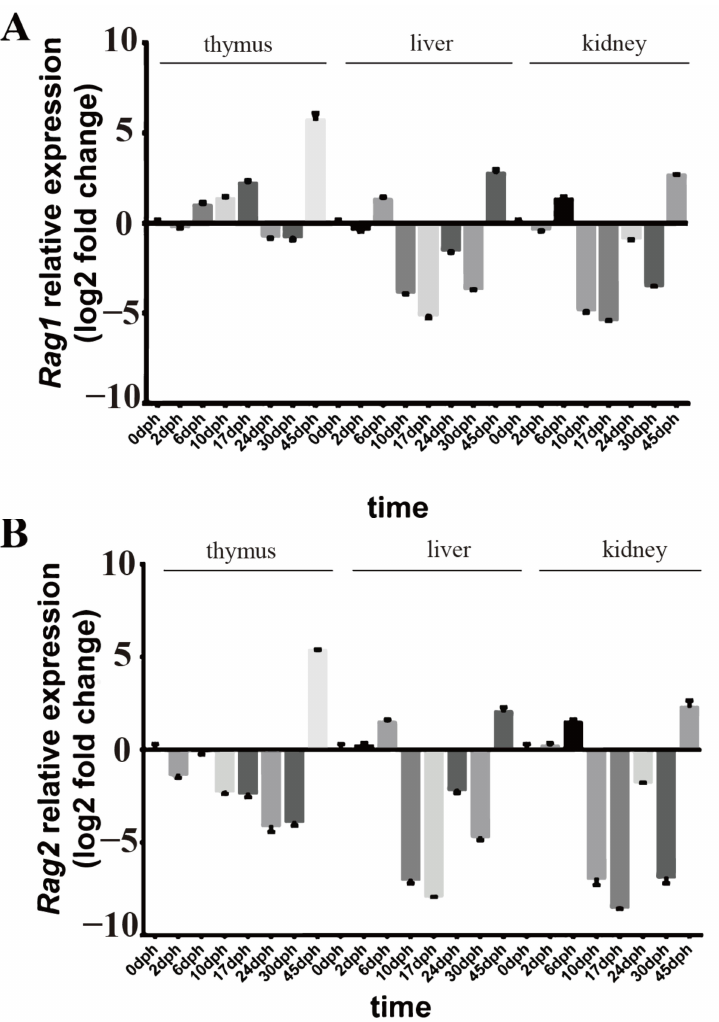
Figure 3. Real-time PCR determined relative mRNA expressions of rag1 ( A ) and rag2 ( B ) in the kidney, liver, and thymus from 0 to 45 dph of rice-field eel, with ef1 α mRNA expression as the internal control. High expression is represented by a positive log2 expression ratio and low expression is represented by a negative log2 expression ratio; n = 3 independent experiments. Data are shown as the mean ± SD (n =